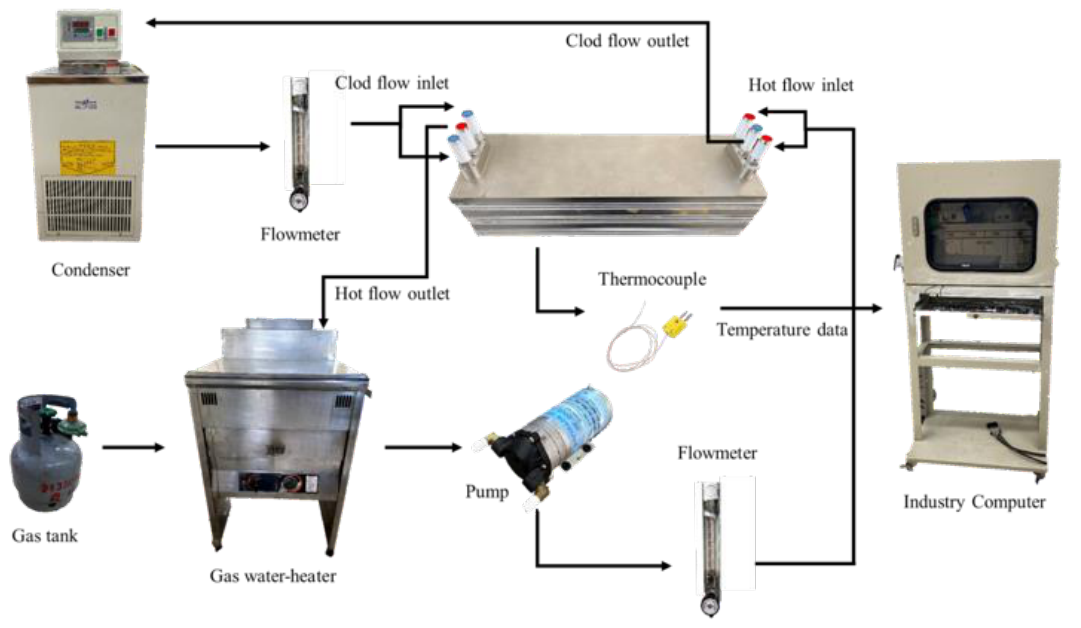
Figure 3. Schematic diagram of the experimental setup.